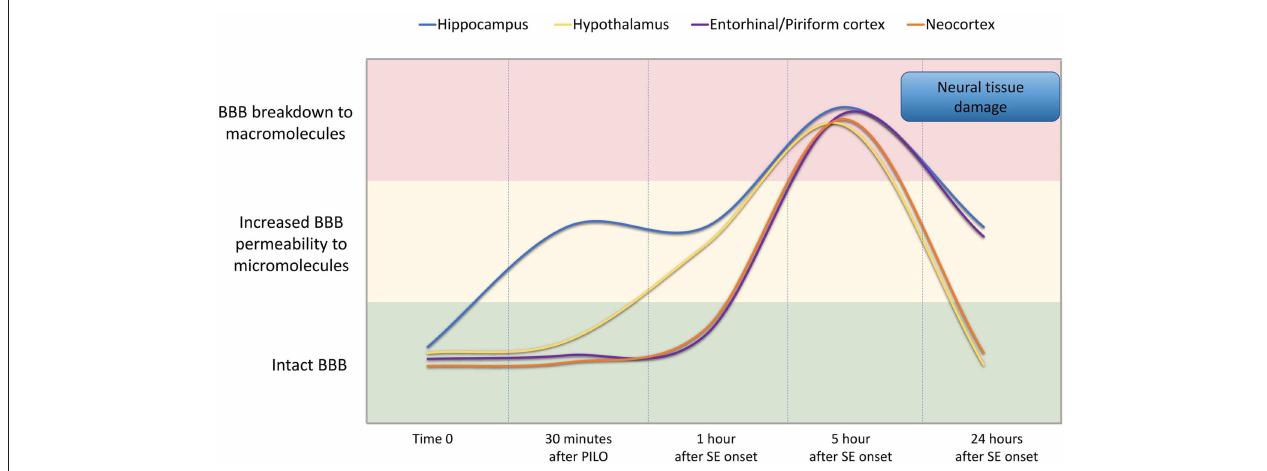
FIGURE 7 | Representation of BBB permeability during the acute phase of the pilocarpine model. The colored bands correspond to the BBB status: intact (green band), increased permeability to micromolecules (yellow band), and breakdown to macromolecules (red band). The lines represent the dynamics of the BBB opening and restoration over time in the regions of the hippocampus (blue line), hypothalamus (yellow line), entorhinal and pyriform cortex (purple line), and neocortex (orange line). Note that increased BBB permeability for micromolecules is observed from 30min after PILO injection, and the BBB breakdown for macromolecules occurs about 5h after SE onset. Although the BBB permeability to macromolecules is restored 24h after SE initiation, the leakage of micromolecules persists and the consequences of BBB degradation on brain tissue are widely disseminated in the brain.